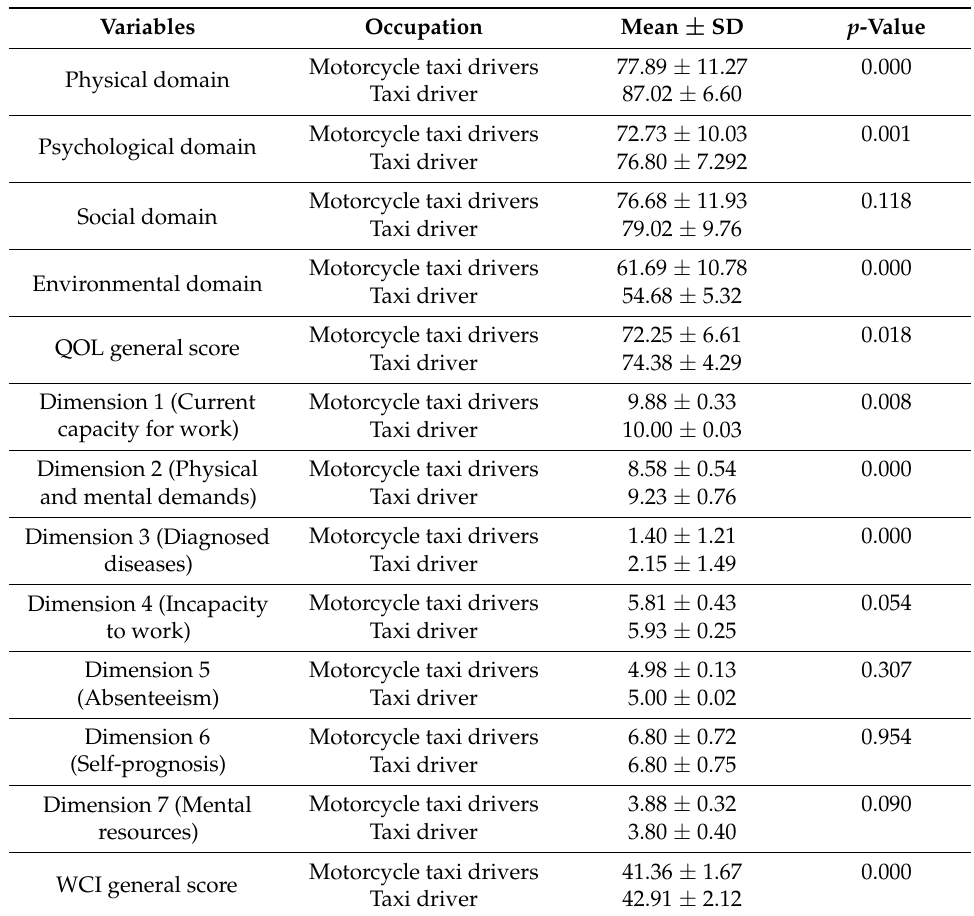
Table 2. Mean values and comparisons between quality of life (QOL) domains and Work Capacity Index (WCI) dimensions.